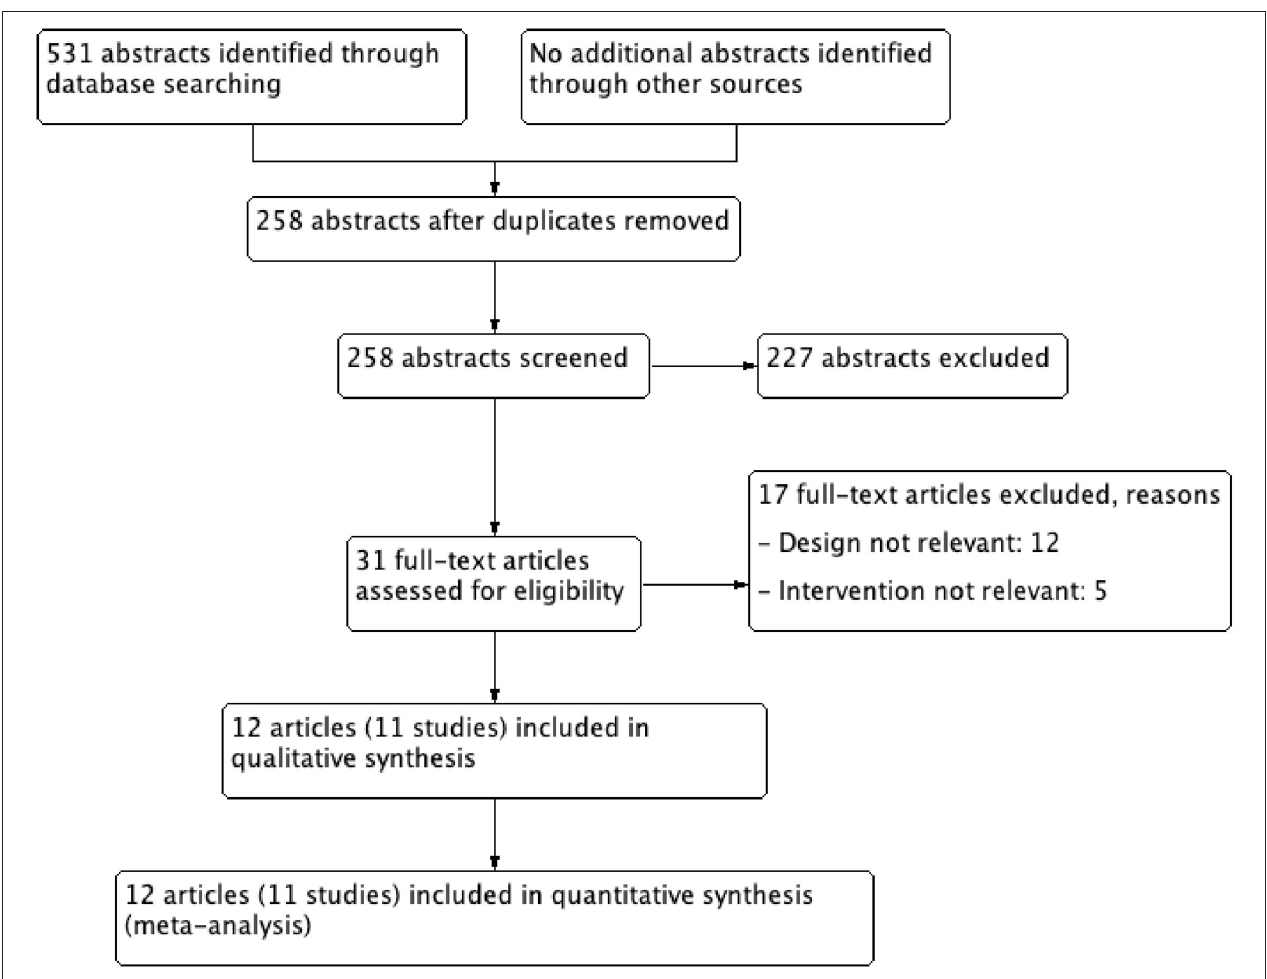
FIGURE 1 | Study flow chart. A total 531 abstracts identified through database searching (PubMed, and Cochrane Library databases), finally 11 studies (12 articles) were included in quantitative synthesis (meta-analysis).